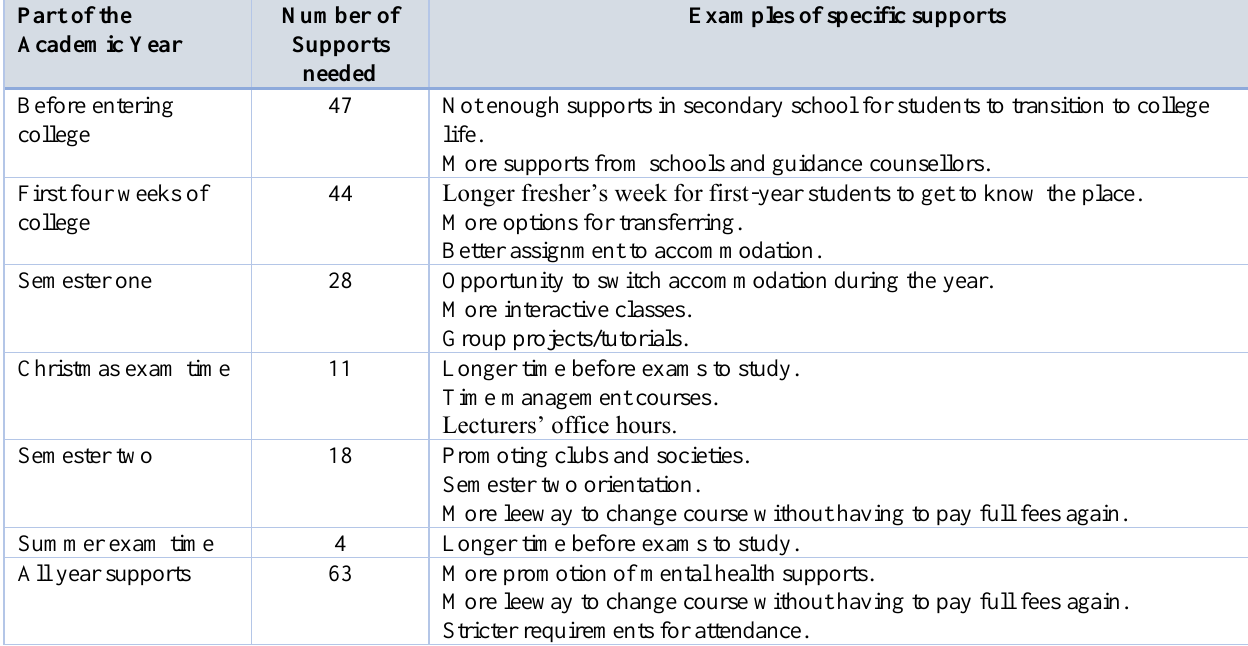
Summary of the Number of Supports Needed During First Year at College with Examples